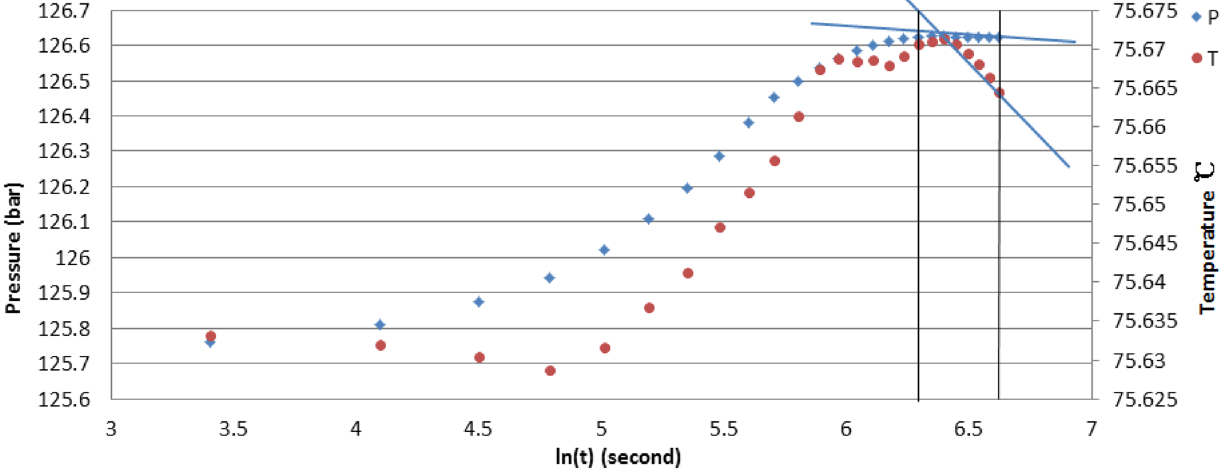
Fig. 16 TTA of transient I: ε ′ = dT / dP = 0.011/0.02 = 0.55